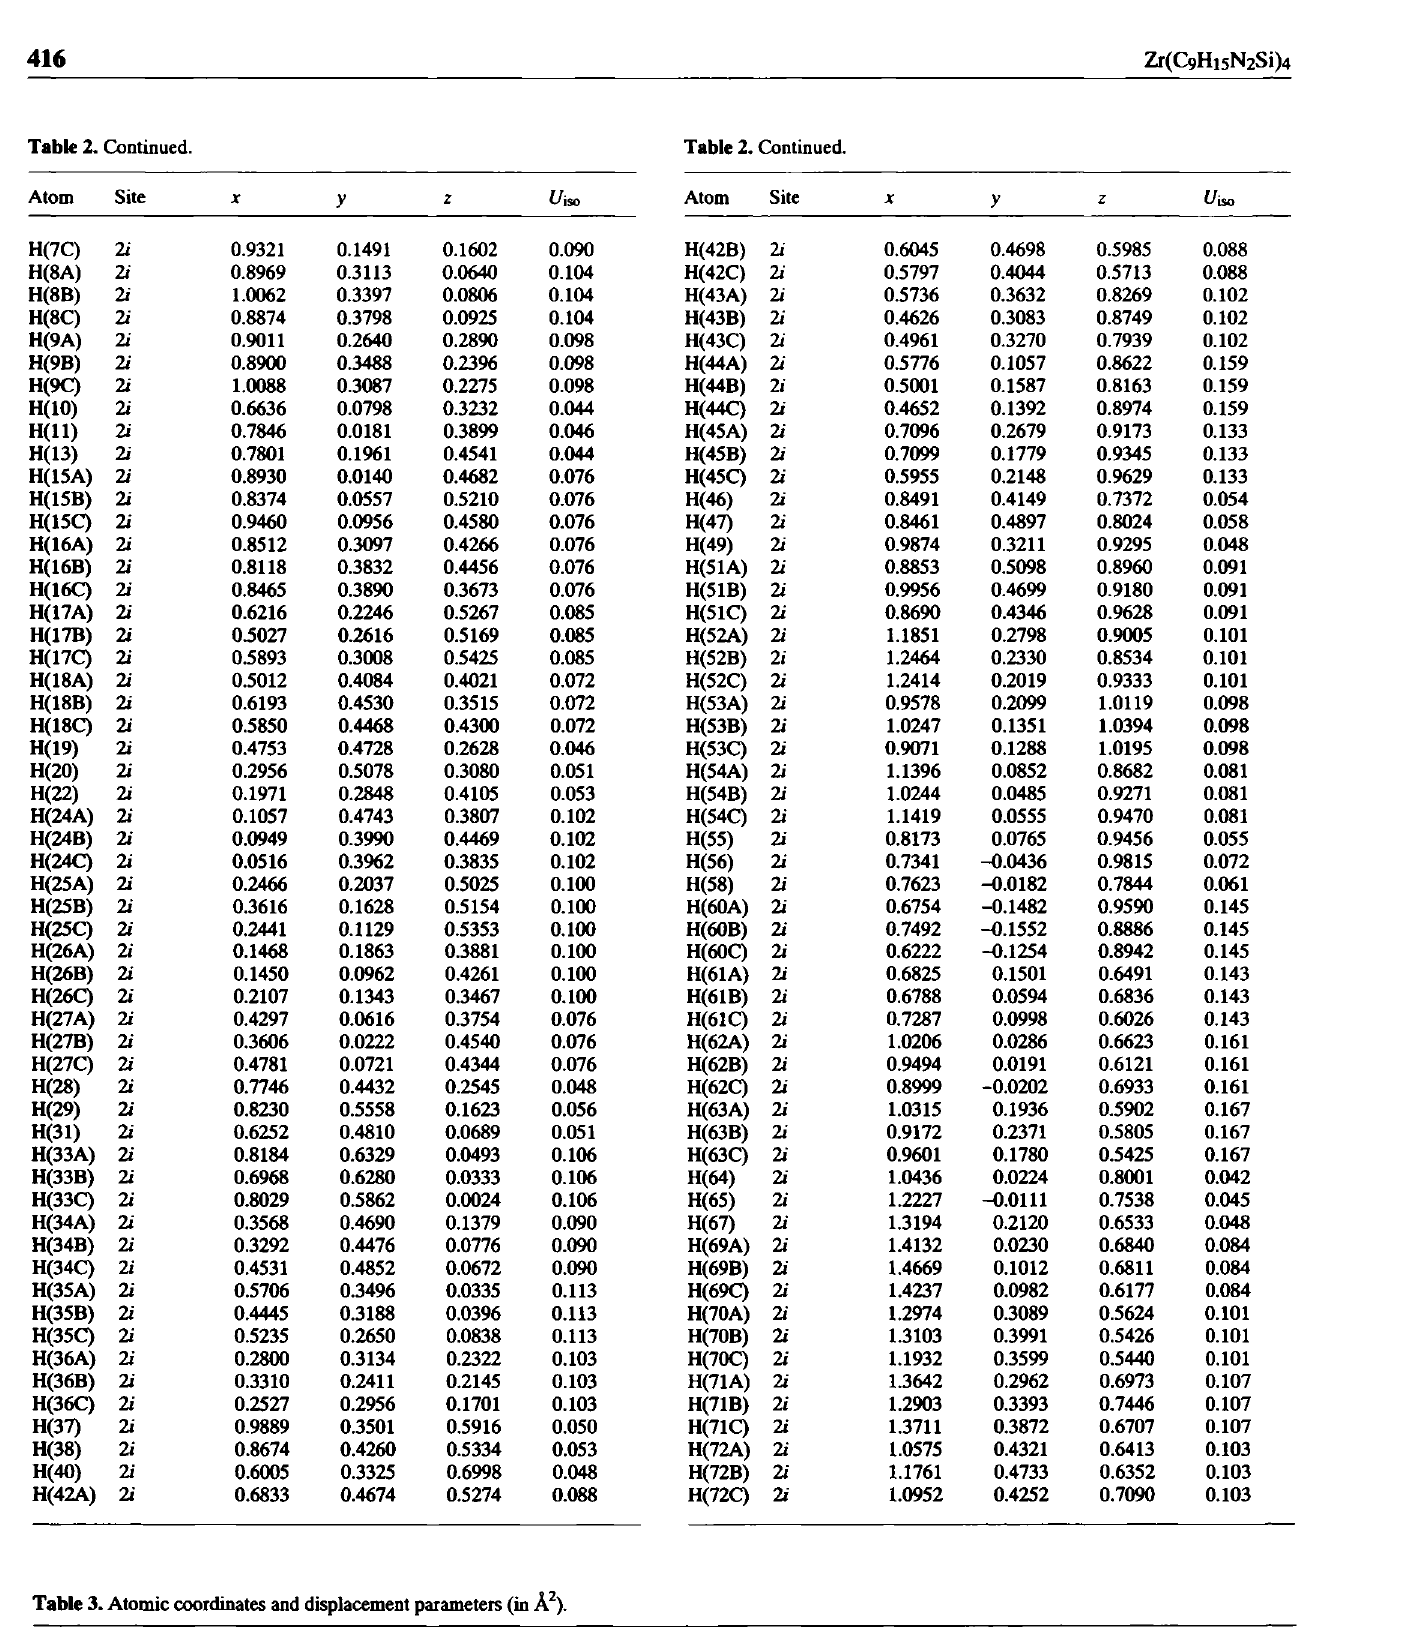
Table 3. Atomic coordinates and displacement parameters (in A 2